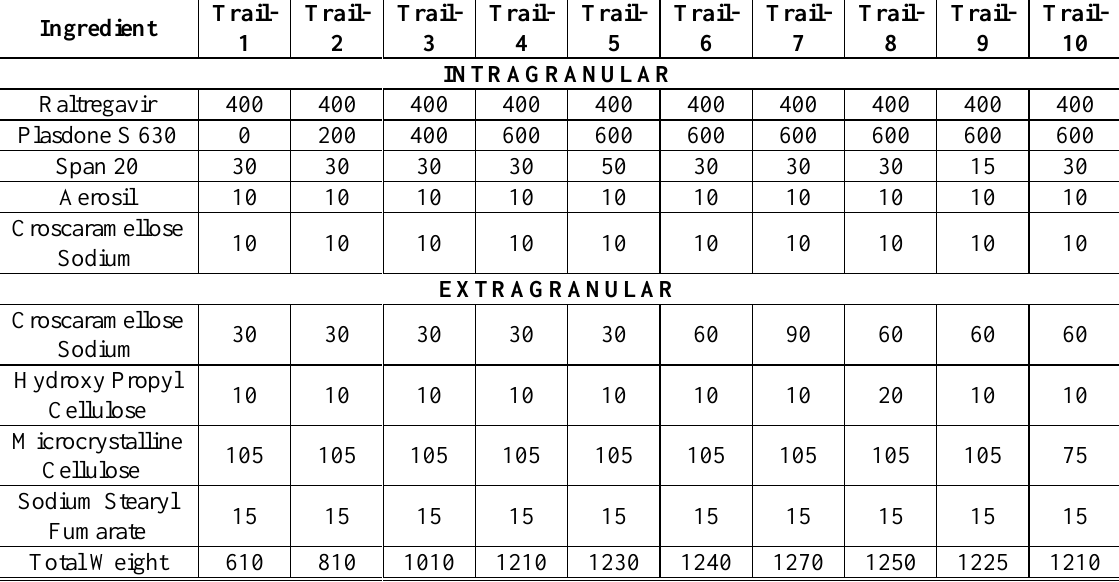
Table 1. HME raltegravir immediate release tablet composition